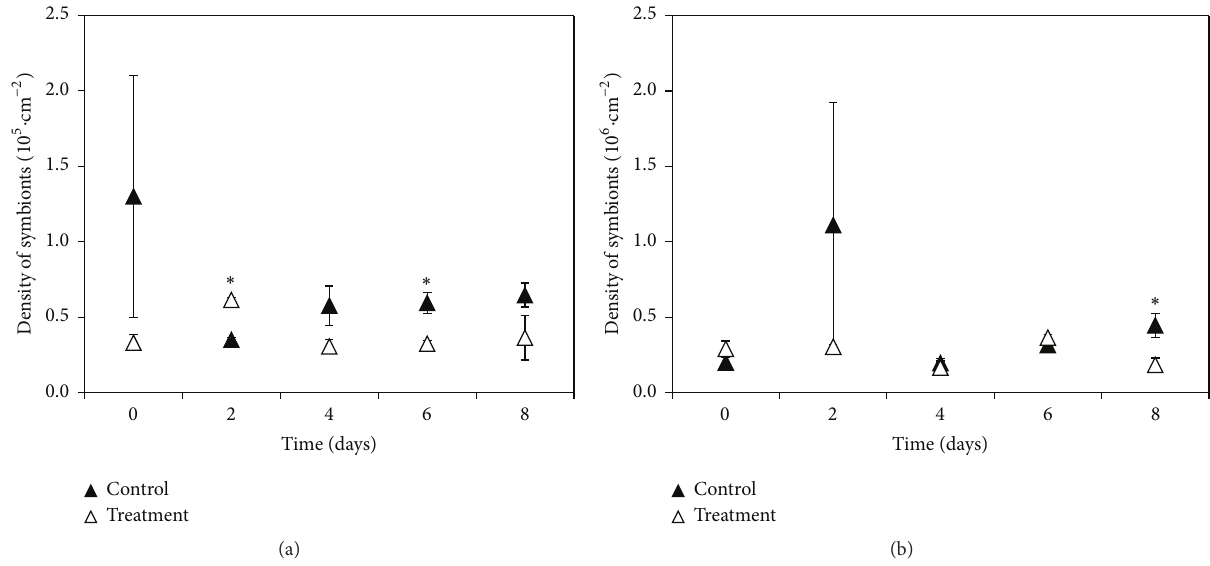
Figure 4: Effect of heat stress on symbiont cell density in Acropora millepora (a) and Pocillopora damicornis (b) incubated in control (filled triangles) and heat stress treatments (open triangles). Error bars represent SD; 𝑛 = 3 coral branches for caspase 3 activity and 𝑛 = 3 coral branches for PAM fluorometry. ∗ Significant difference (post hoc LSD analysis, 𝑝 = 0.05 ) between treatment and control for the same time point.